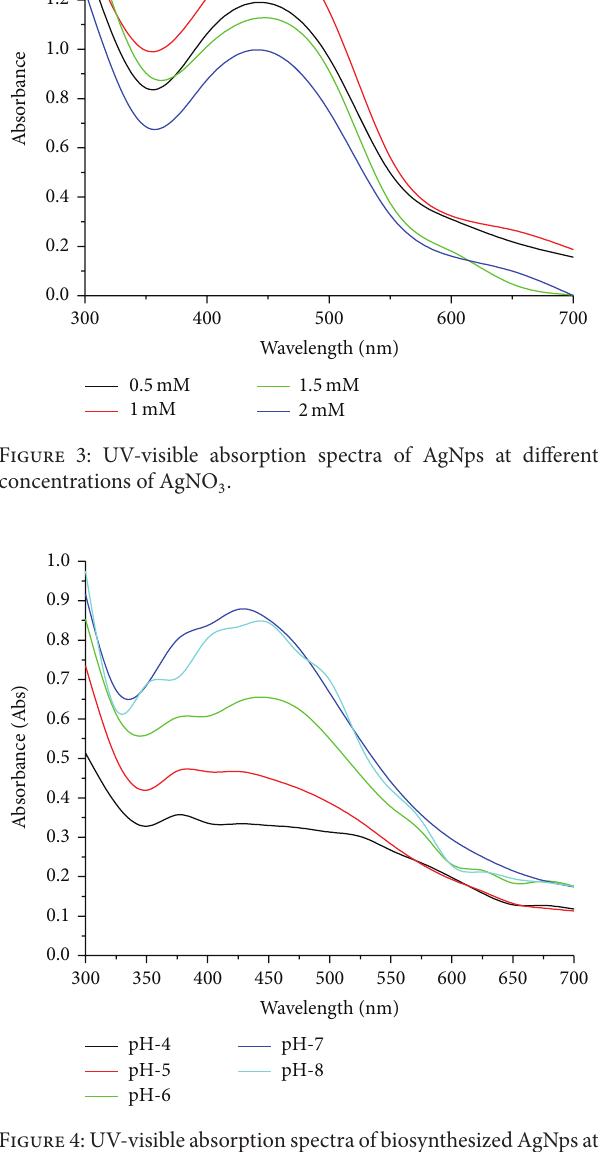
Figure 4: UV-visible absorption spectra of biosynthesized AgNps at different at pH.